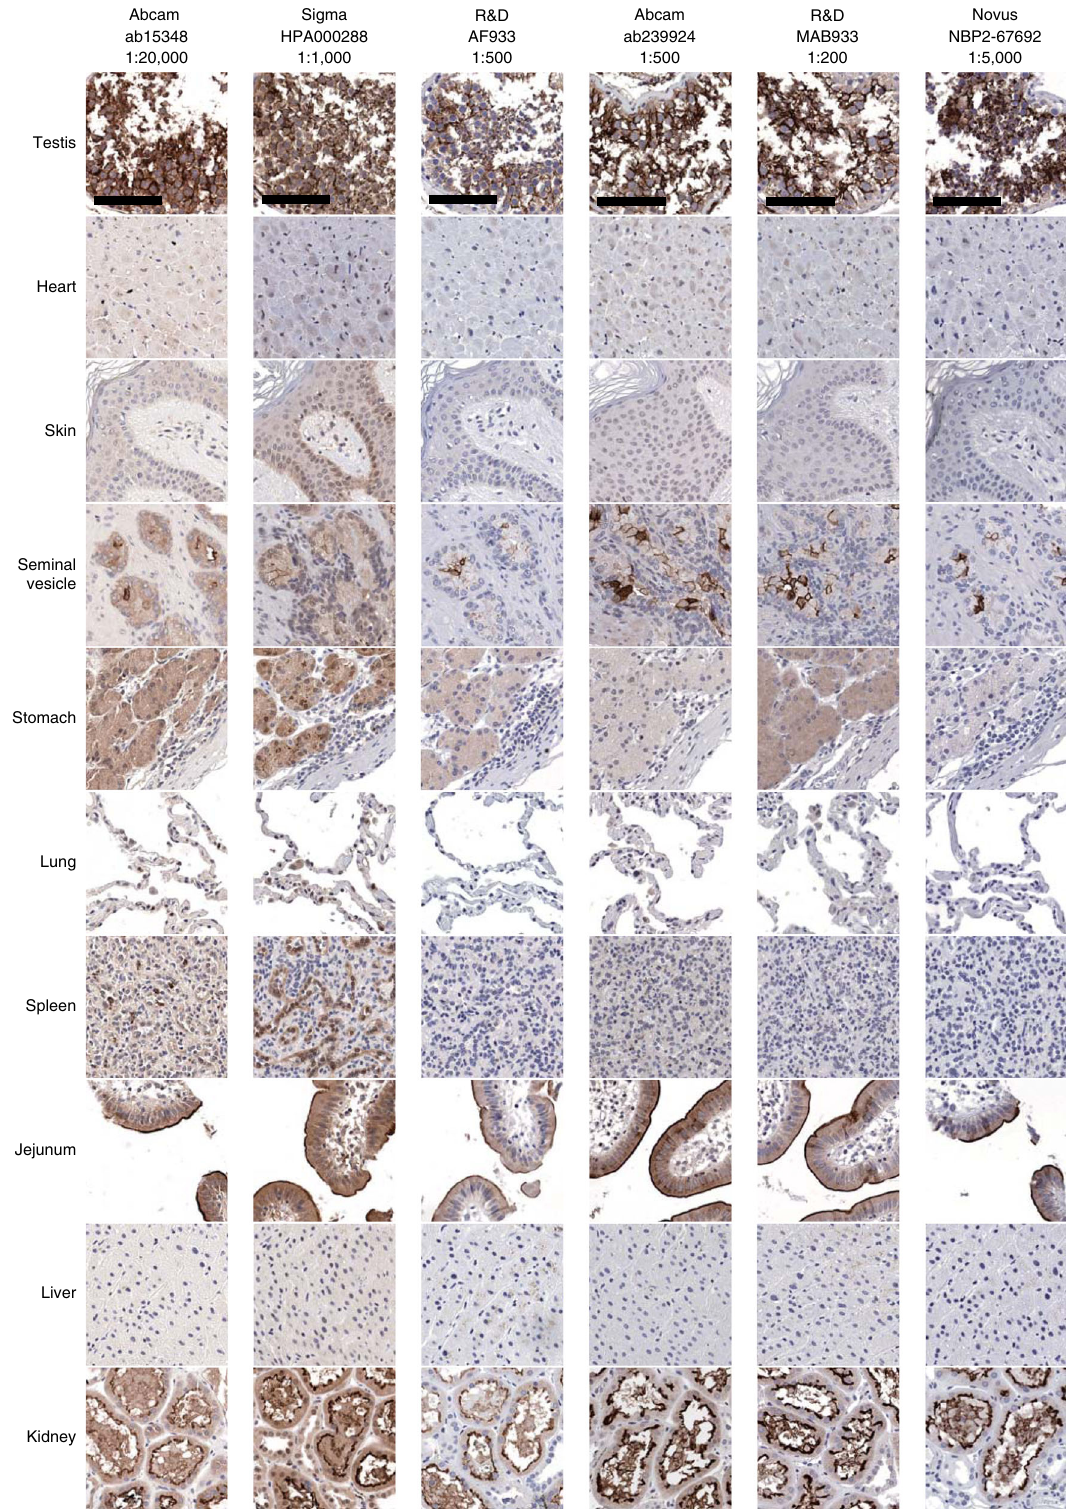
Fig. 1 Immunohistochemical analysis of ACE2 protein localization across human tissues using multiple anti-ACE2 antibodies. Representative images of human tissues on a tissue microarray (TMA) stained by chromogenic immunohistochemistry using antibodies targeting the ACE2 protein (brown) and counterstained with hematoxylin (blue). Highest ACE2 expression was observed in the villi of the intestinal tract (jejunum), renal tubules, testis, and glandular cells in the seminal vesicle. Minimal to no/non-speci fi c staining can be seen in the heart, stomach, spleen, skin, and liver. Staining of lung pneumocytes was observed using Abcam ab15348, and less speci fi cally with Sigma HPA000288 (Fig. 2b; Supplementary Table 1). Scale bars: 100 μ